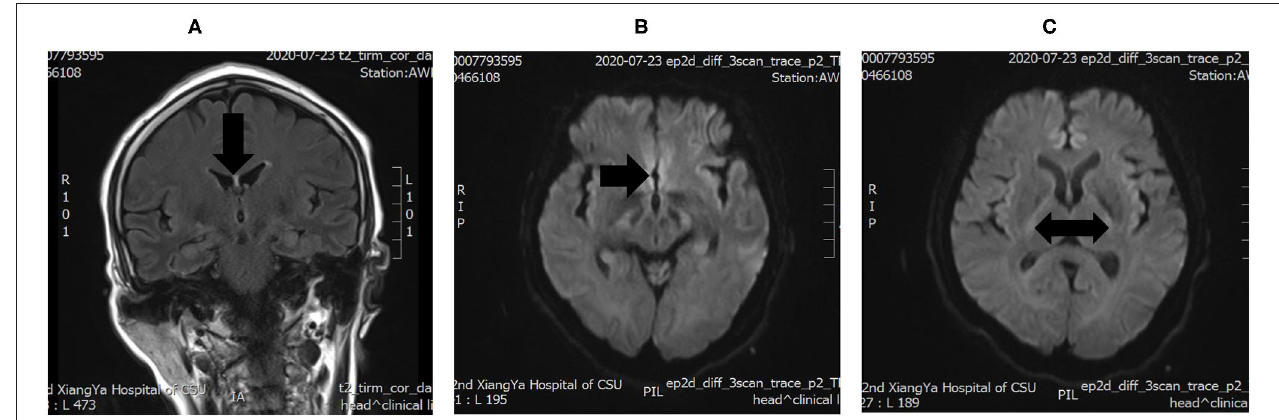
FIGURE 1 | (A) increased T2 signals in the periventricular region around the third ventricle. (B,C) Diffusion-weighted imaging (DWI) showing Wernicke’s encephalopathy (WE) changes in the bilateral basal ganglia.